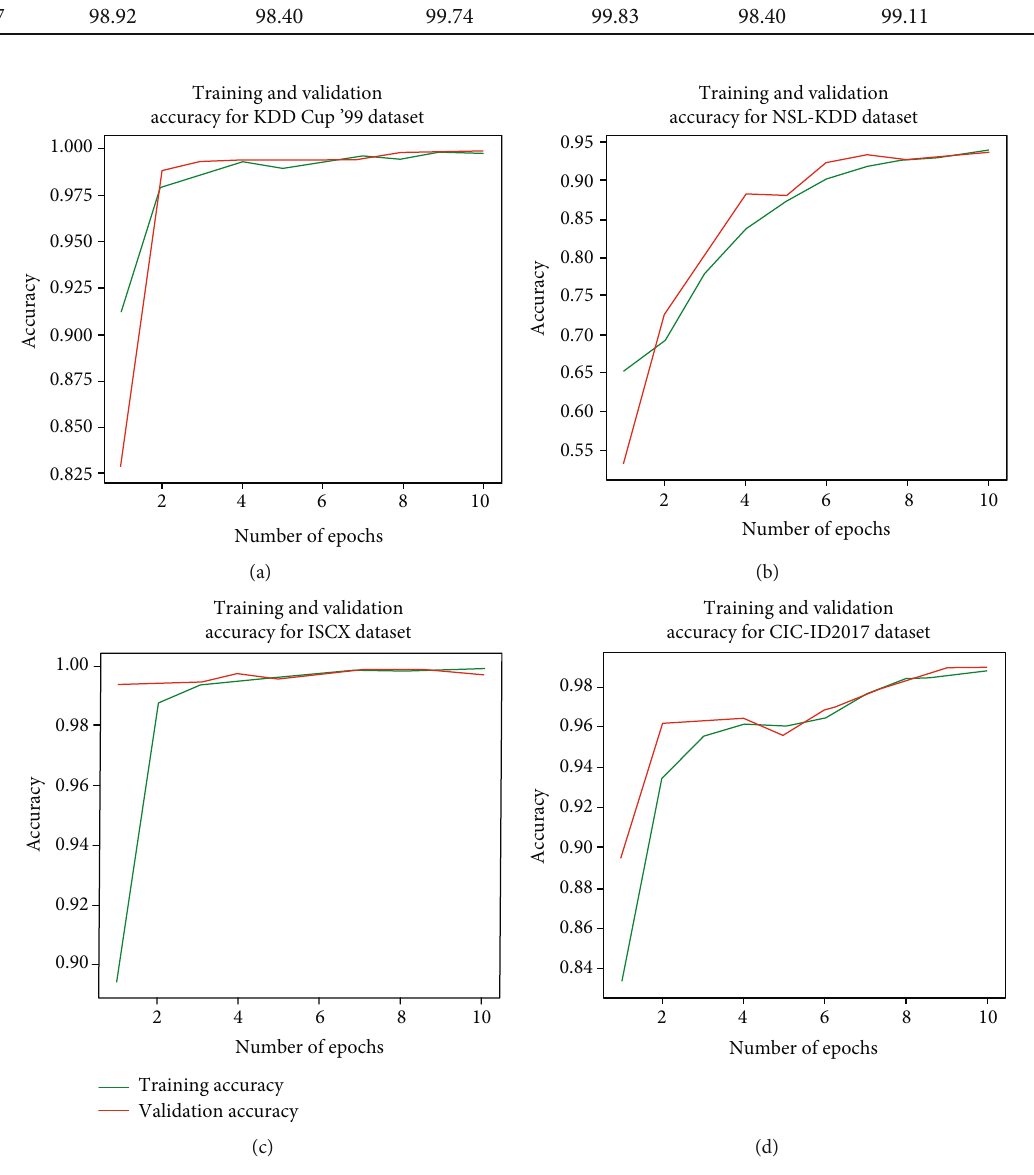
Figure 8: Performance of LSTM-RNN model for testing